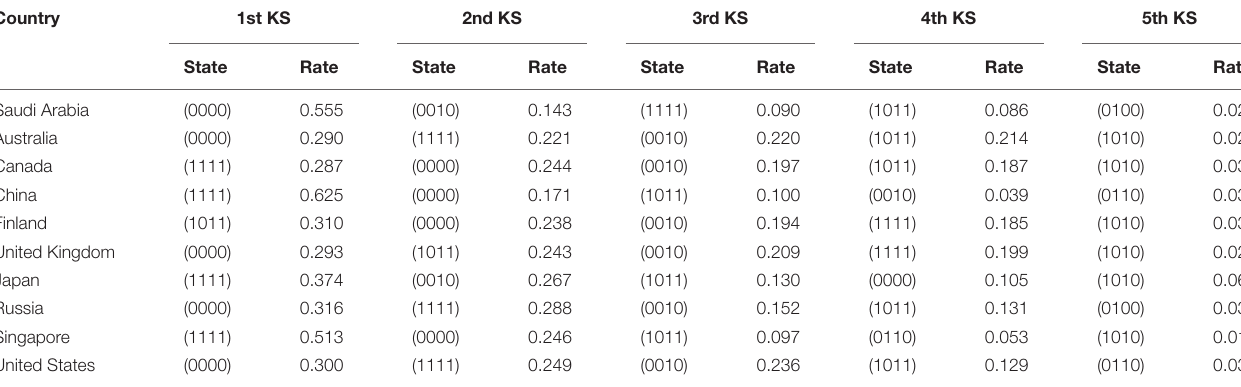
TABLE 7 | Knowledge states of the top five context attributes of 10 countries.